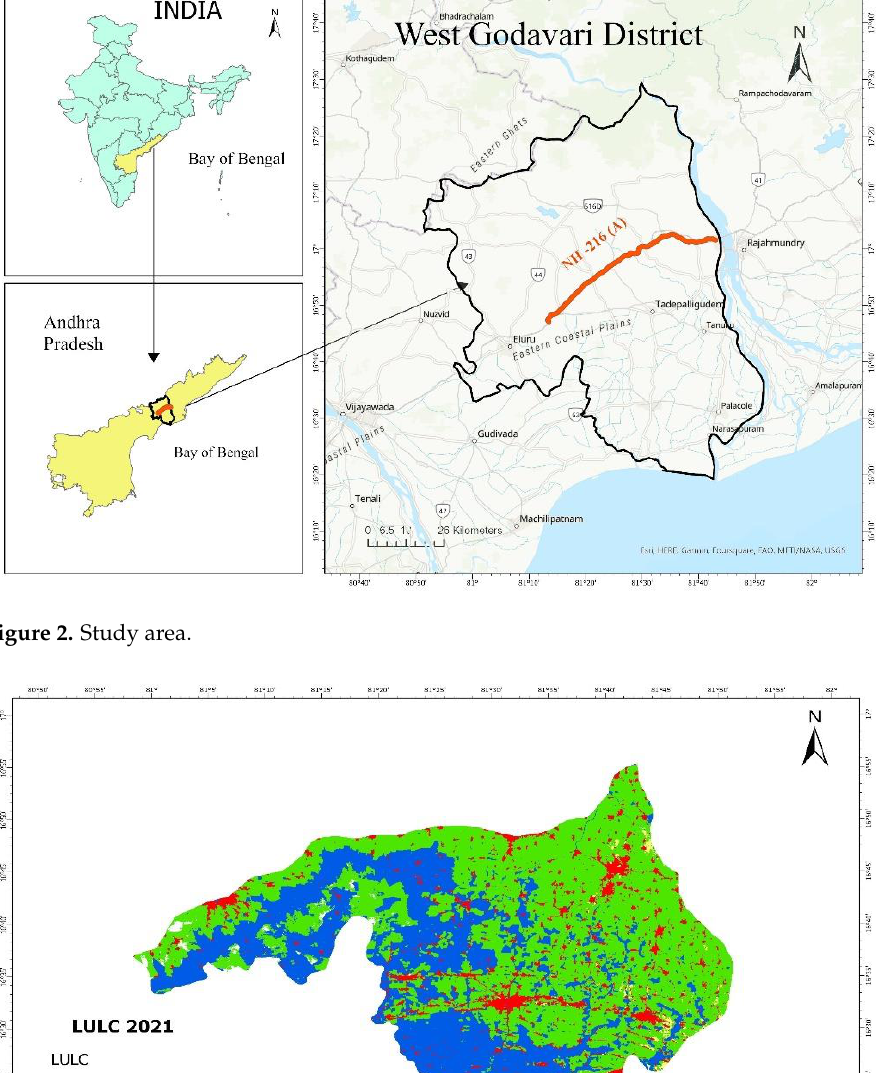
Figure 3. Land use land cover of delta region of West Godavri district.